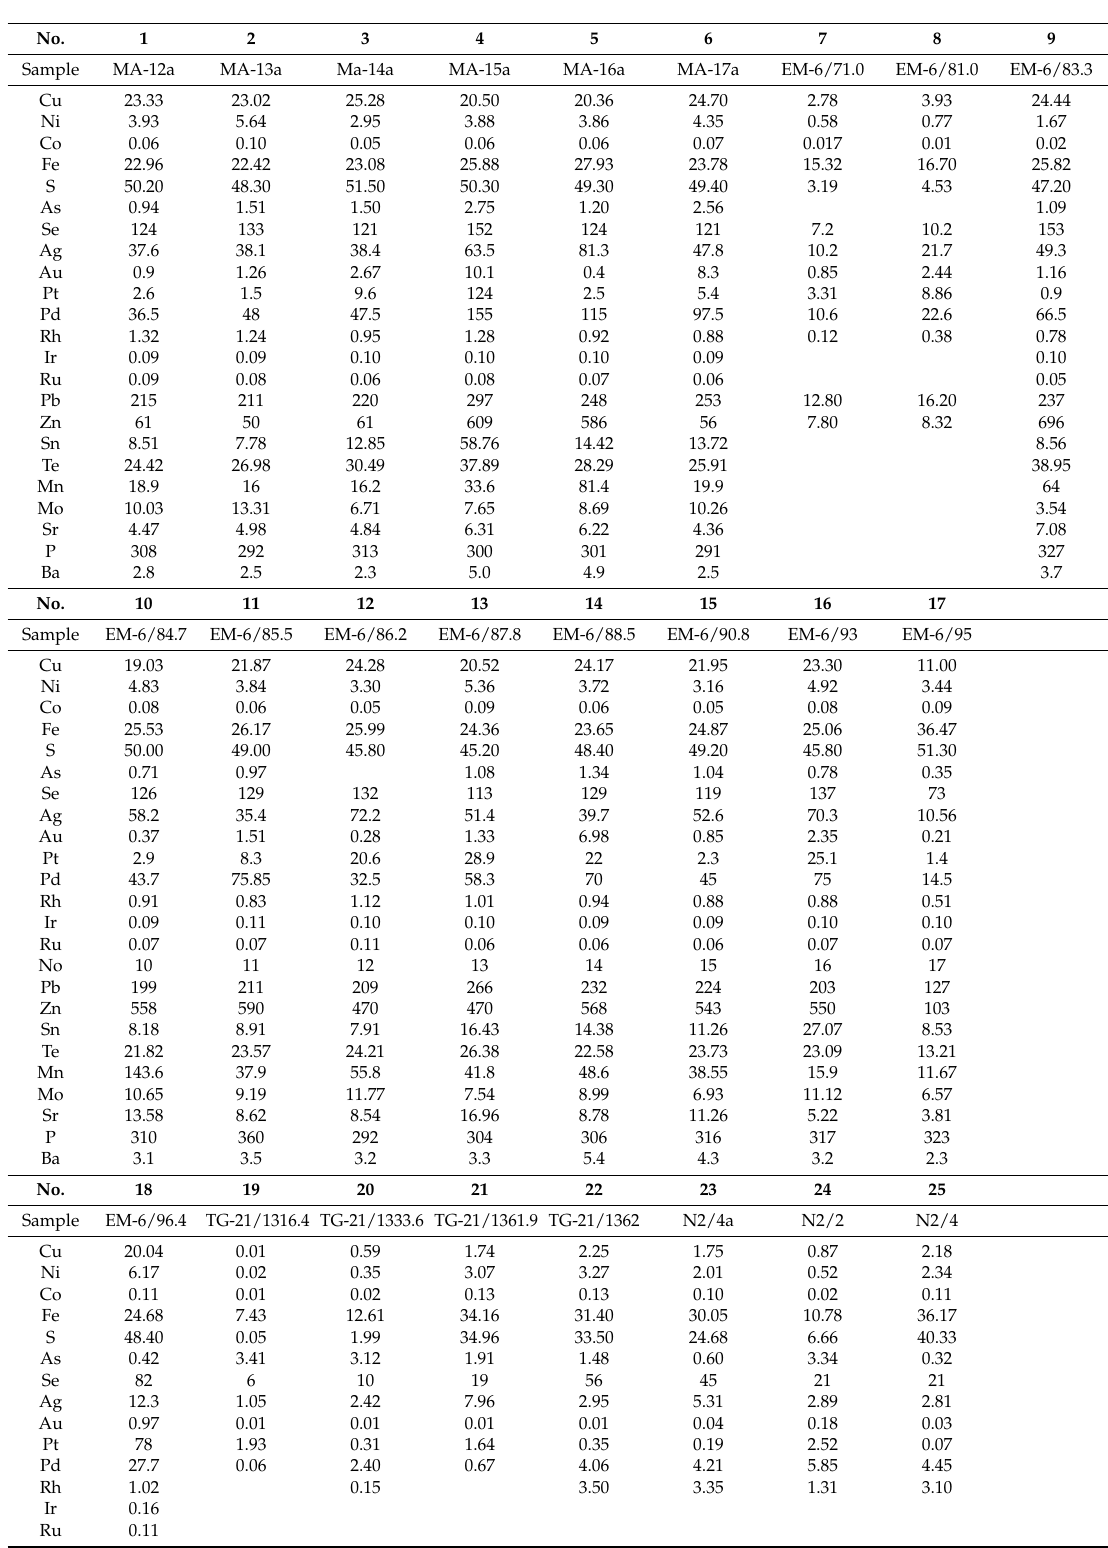
Table 3. Chemical composition of sulfide